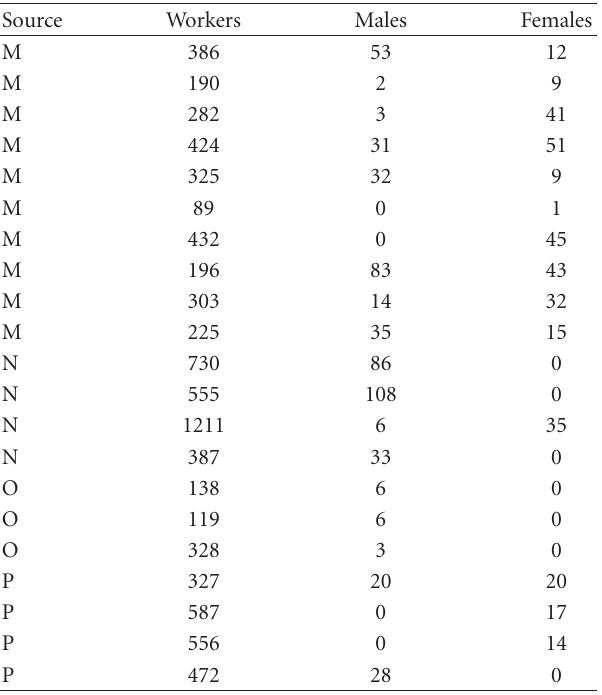
Table 3: The production of sexual adults in queenless field colonies. Data are from 4 populations: M: Mohegan SF (2004); N: Nipmuck SF (2001); O: Ohio (1949) [25]; P: Pachaug SF